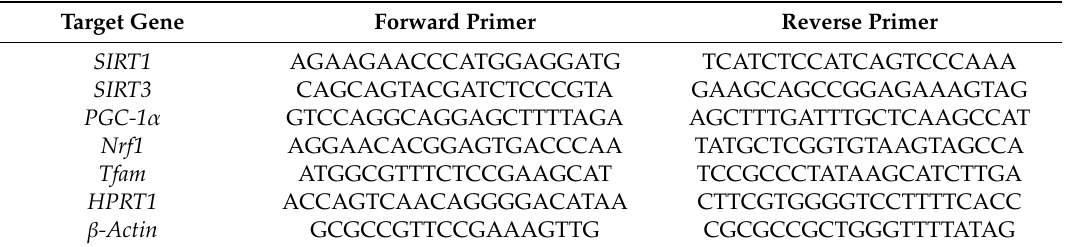
Table 2. Primers used for quantitative